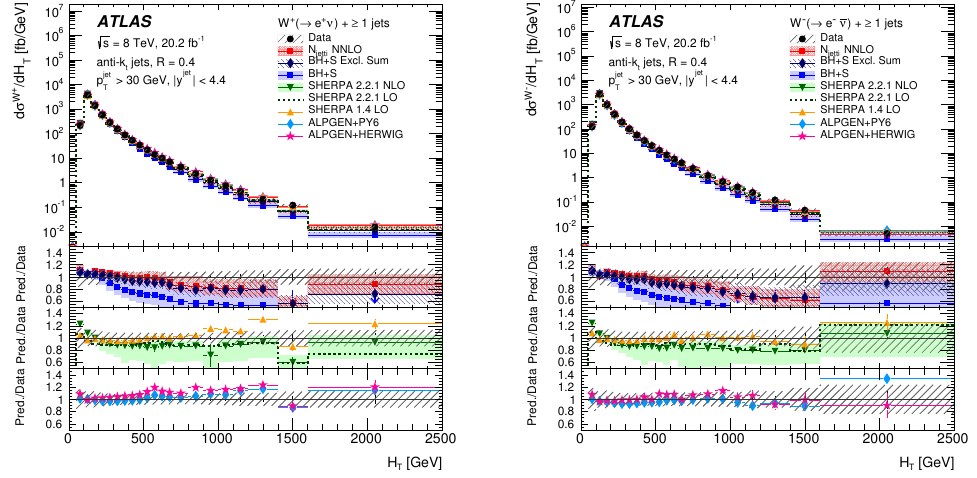
Figure 17 . Di(cid:11)erential cross sections for the production of W + (left) and W (cid:0) (right) as a function of the H T for events with N jets (cid:21) 1. For the data, the statistical uncertainties are indicated as vertical bars, and the combined statistical and systematic uncertainties are shown by the hatched bands. The uppermost panel in each plot shows the di(cid:11)erential cross sections, while the lower panels show the ratios of the predictions to the data. The theoretical uncertainties on the predictions are described in the text. The arrows on the lower panels indicate points that are outside the displayed range.